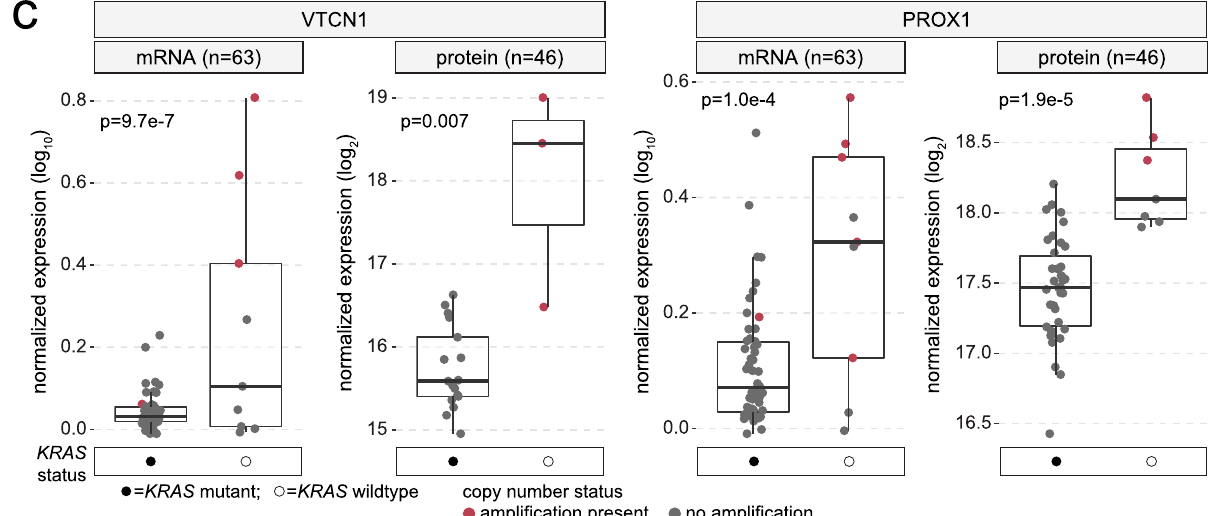
of CNV analysis between KRAS wildtype versus mutant tumors. Two-tailed Wil- coxon mean rank-sum p values are shown. c Box plots comparing mRNA and proteinlevelsbetween KRAS wildtypeandmutantgroupsfor VTCN1 (mRNA: KRAS wildtype n =9, KRAS mutant n =54; protein: n =3 and n =17) and PROX1 (mRNA: n =9, n =54;protein: n =7 and n =38). Each dot represents a sample, and dots are colored based on whether copy ampli fi cation of the gene was present. Box plots indicate median (central line), 25 – 75% IQR (bounds of box), and whiskers extend fromboxboundstothelargestvaluenofurtherthan1.5timesthe IQR.Two-tailed Wilcoxon mean rank-sum p values are shown. Source data are provided as a Source Data fi